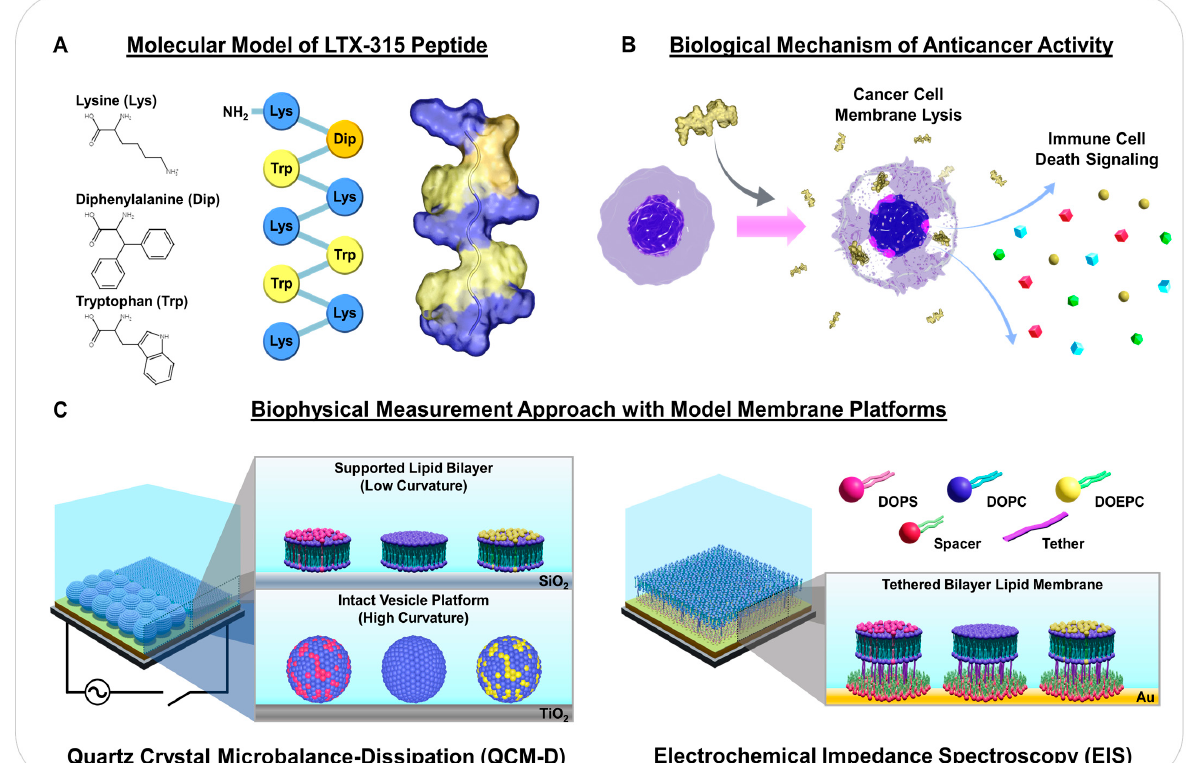
Figure 1. Overview of LTX-315 anticancer peptide and experimental strategy: ( A ) amino acid struc- tures, sequence, and 3D molecular model of LTX-315 peptide. Hydrophobic (Trp and Dip) and cationic (Lys) amino acids are depicted in yellow and blue, respectively; ( B ) proposed biological mechanism of how LTX-315 peptide exhibits anticancer activity based on cancer cell membrane disruption; and ( C ) experimental strategy to track membrane-peptide interactions using the supported lipid bilayer (low curvature), intact vesicle (high curvature), and tethered bilayer lipid membrane platforms with different membrane surface charges. Measurements were conducted using the quartz crystal microbalance-dissipation (QCM-D) and electrochemical impedance spectroscopy (EIS) techniques.